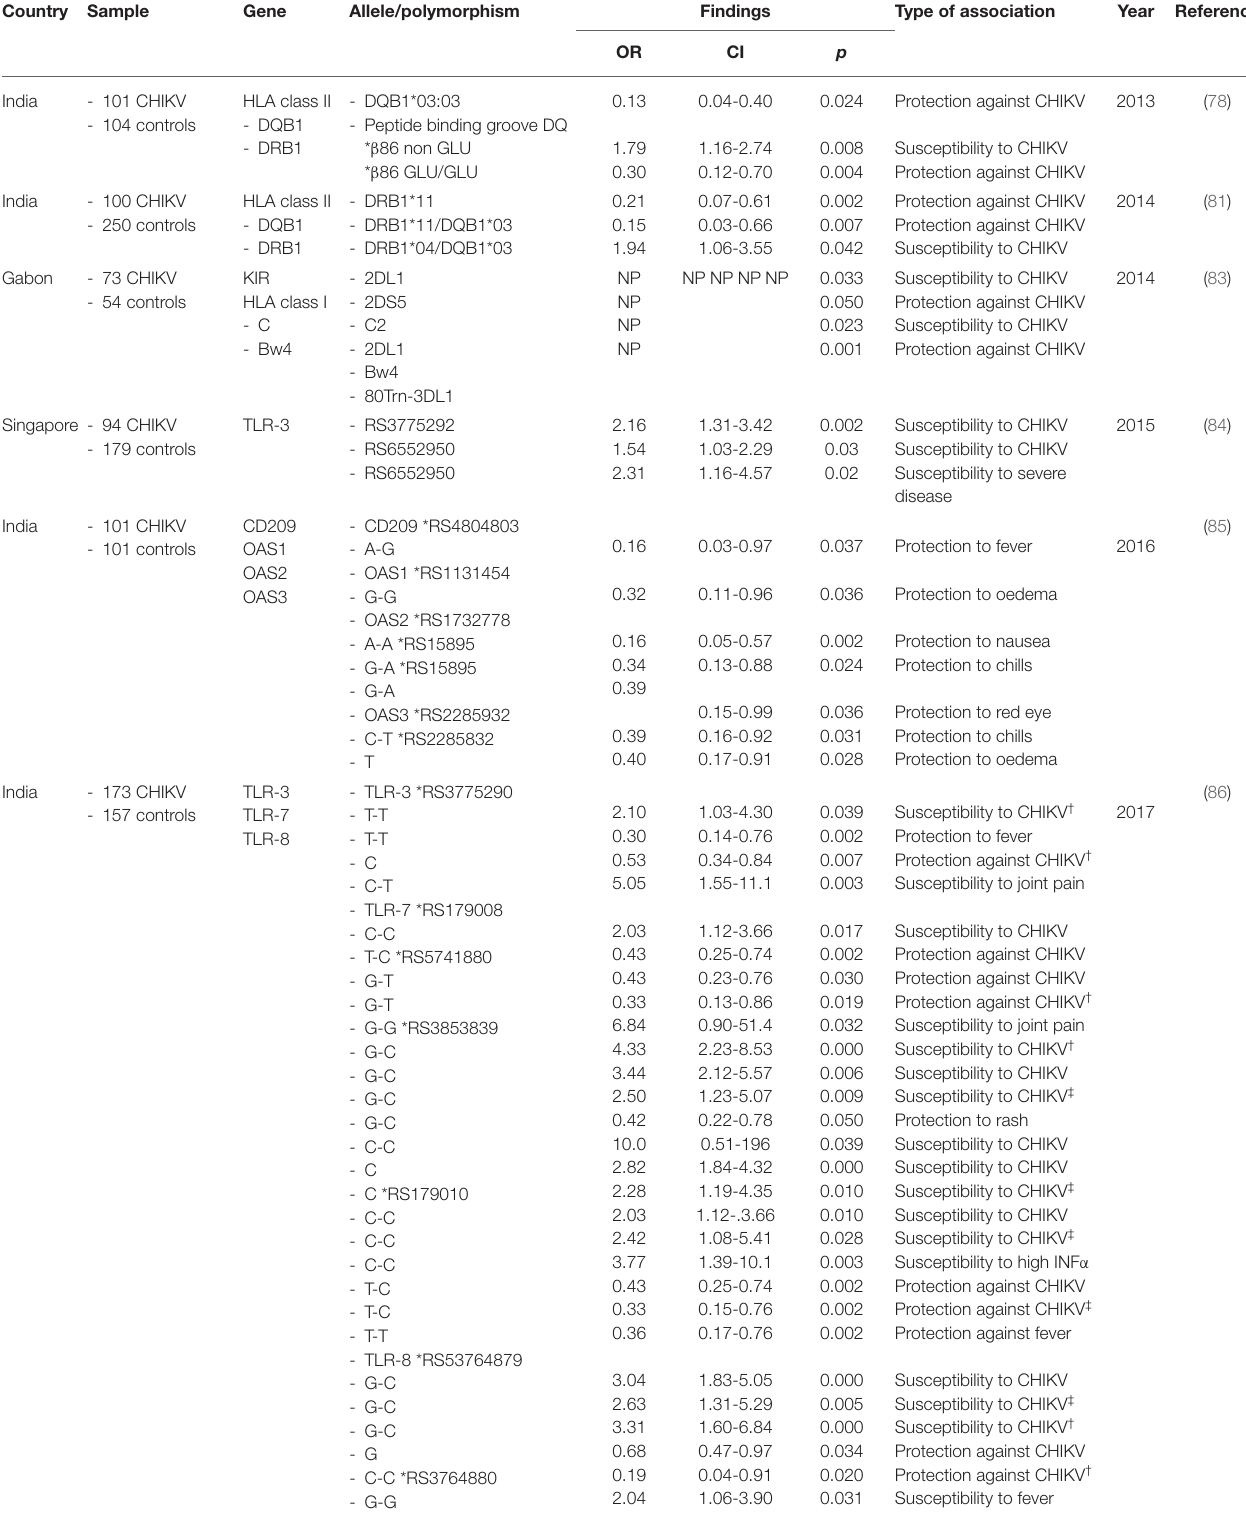
TABLE 1 | Genetic studies on host and CHIKV infection. Country